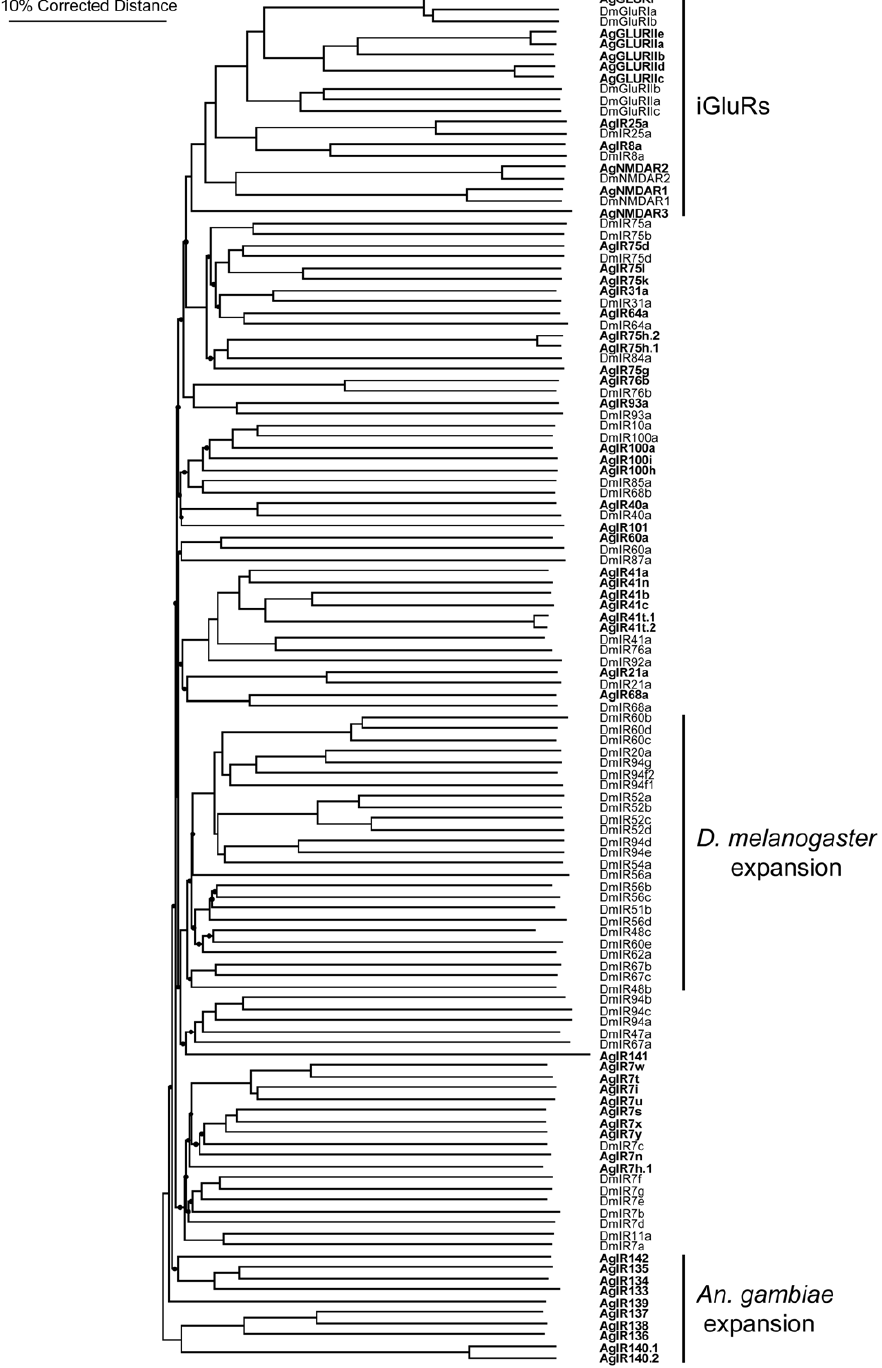
Figure 8. AgIR/DmIR phylogenetic tree. Neighbor-joining tree based on amino acid alignments of AgIR and DmIR peptides. AgIR names are shown in bold type and DmIR names are shown in plain type. Black dots indicate branch points where bootstrap support is less than 50%.